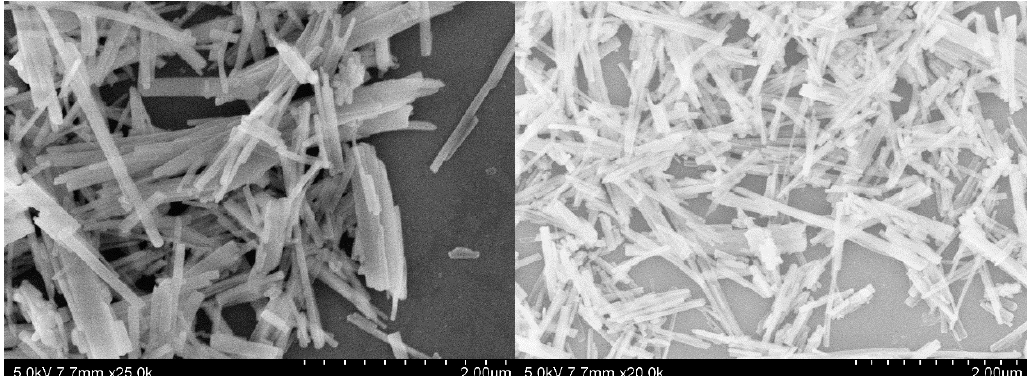
Figure 1. SEM images of EuBTC ( left )and RS6h@EuBTC ( right ).